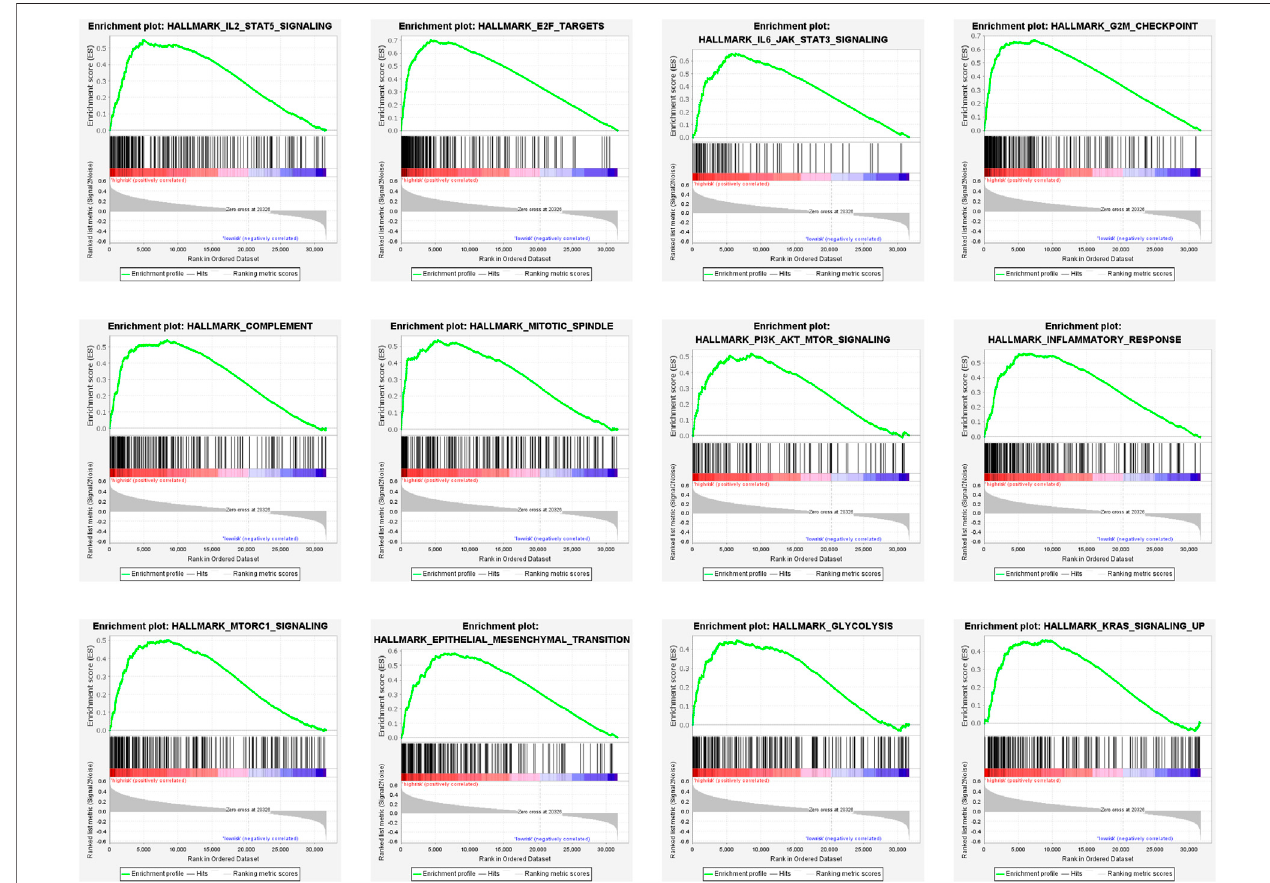
FIGURE 9 | Gene set enrichment analysis (GSEA) of DEGs in the high-risk